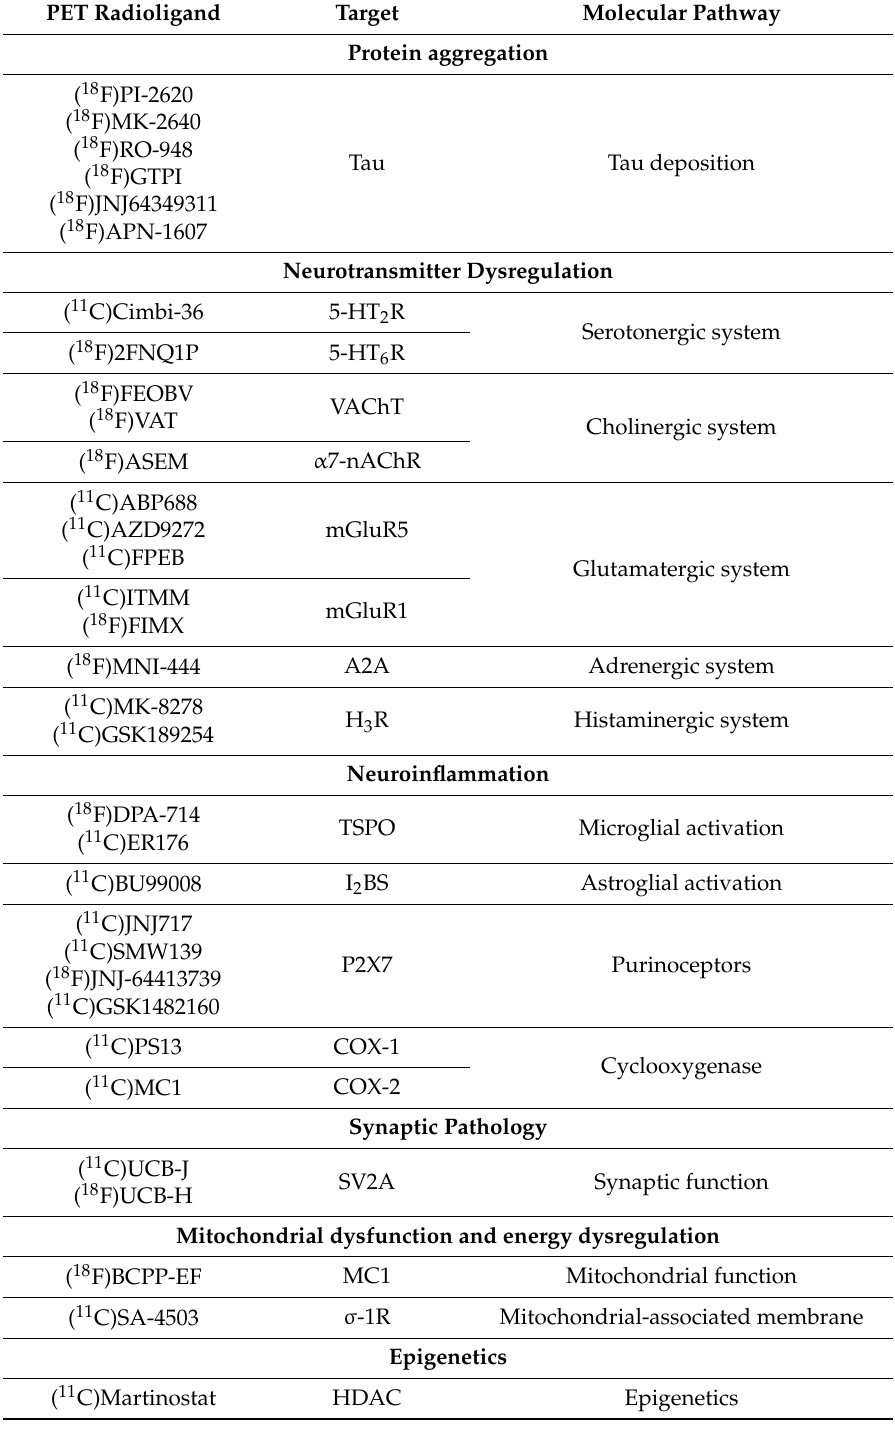
Table 1. Overview of new PET radioligand for novel targets and related molecular pathways across age-related neurodegenerative